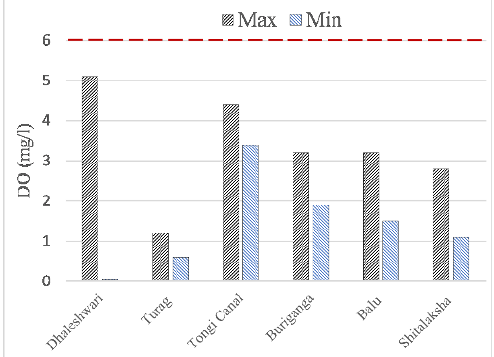
Figure 6 . Max m vs. Min m Concentration DO of peripheral rivers of Dhaka with WHO standards (6 mg/L).